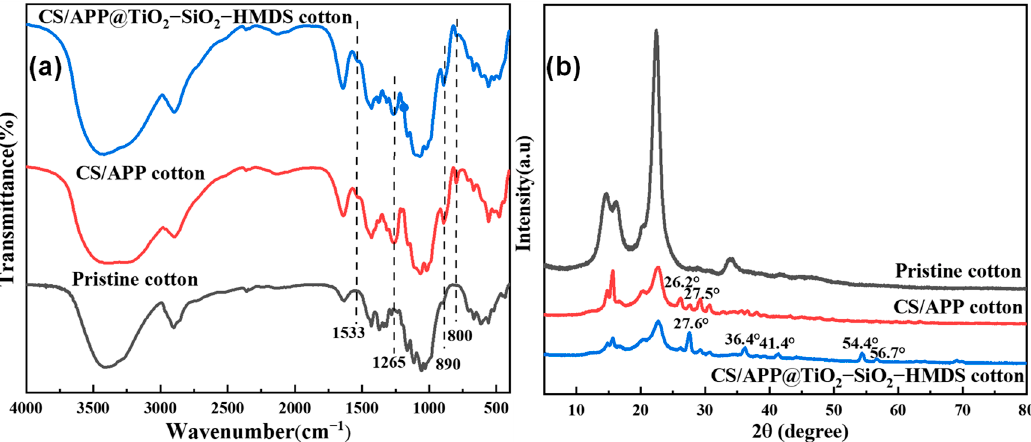
Figure 3. ( a ) FTIR of spectra of the pristine cotton, CH/APP cotton and CH/APP@TiO 2 -SiO 2 -HMDS cotton, ( b ) X-ray diffraction spectra of the pristine cotton, CH/APP cotton and CH/APP@TiO 2 -SiO 2 - HMDS cotton. HMDS